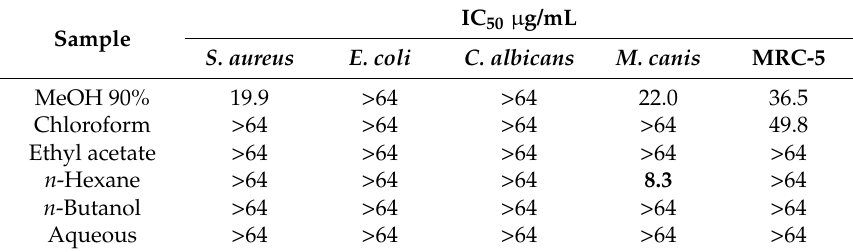
Table 1. Antibacterial, antifungal and cytotoxic activities of Ferula narthex fractions.